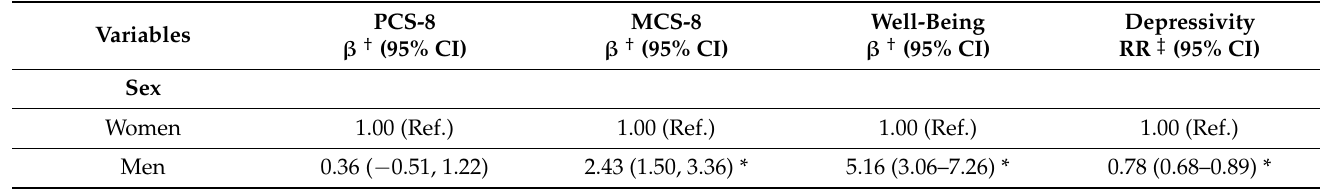
Table 8. Associations between gender, age, and socioeconomic status on health-related quality of life and